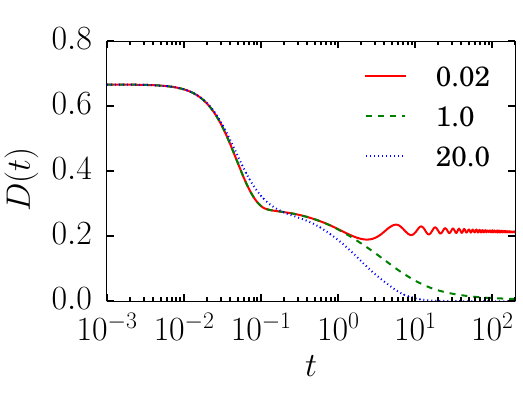
( 0 ) = | ψ 〉〈 ψ | and ρ ( 0 ) = | ψ 〉〈 ψ | N N 1 0 0 2 = 4 ( N = 16) particles. Time t has been made (cid:69) S / ħ h ≡ t . Non-monotonicity is a signature of and ħ h , i.e. t (cid:48) → t (cid:48) J S S